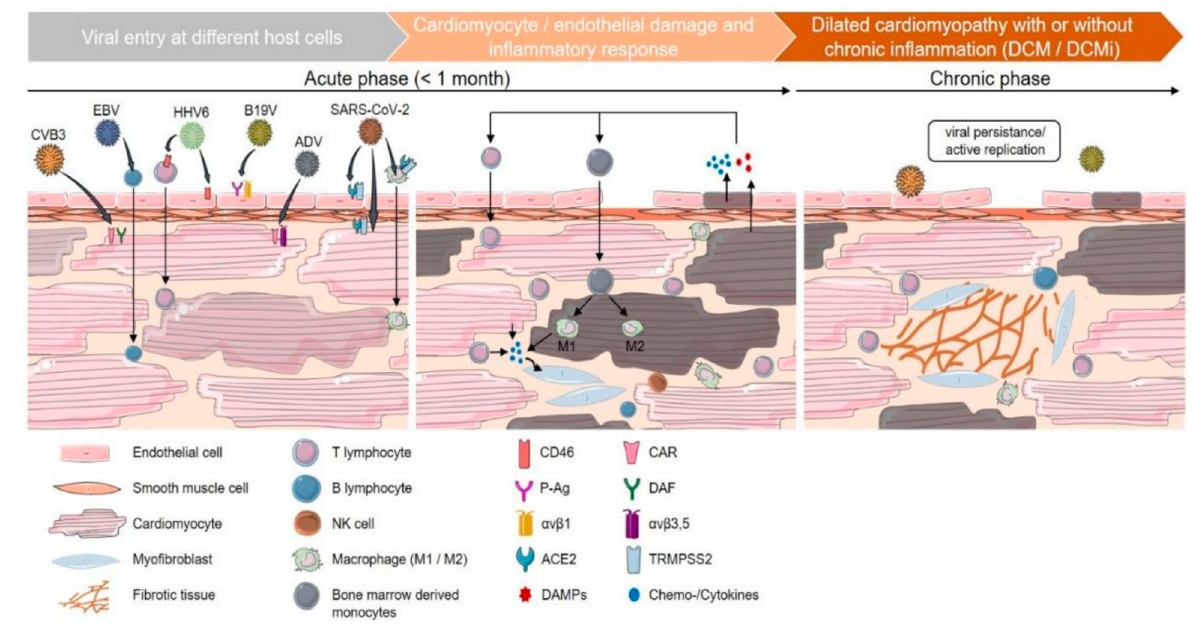
Figure 4. Chronic inflammatory cardiomyopathy: Acute phase showing entry routes of different pathogens—coxsackievirus B3 (CVB3), Epstein–Barr virus (EBV), human herpesvirus 6 (HHV6), parvovirus B19 (B19V), adenovirus (ADV), severe acute respiratory syndrome coronavirus 2 (SARS-CoV-2), through cell surface receptors or inflammatory cells, resulting in direct and indirect cardiomyocyte damage. This is followed by cytokine and damage-associated molecular pattern (DAMP) release, triggering infiltration with T-lymphocytes and monocytes, which differentiate into M1 or M2 macrophages. Inflammation-promoted cytokine release leads to activation of myofibroblasts; Chronic phase showing viral and/or inflammatory process persistence contributing to loss of cardiomyocytes and production of fibrotic tissue, which results in cardiomyopathy. Figure replicated from [23] under Creative Commons license, provided at https://creativecommons.org/licenses/by-nc/4.0/ (accessed on 1 February 2022). Changes made: Figure legend.